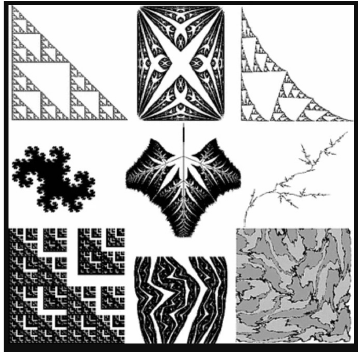
Figure 1. Fractal